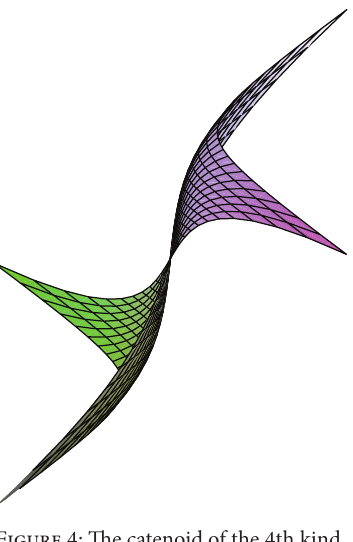
Figure 4: The catenoid of the 4th